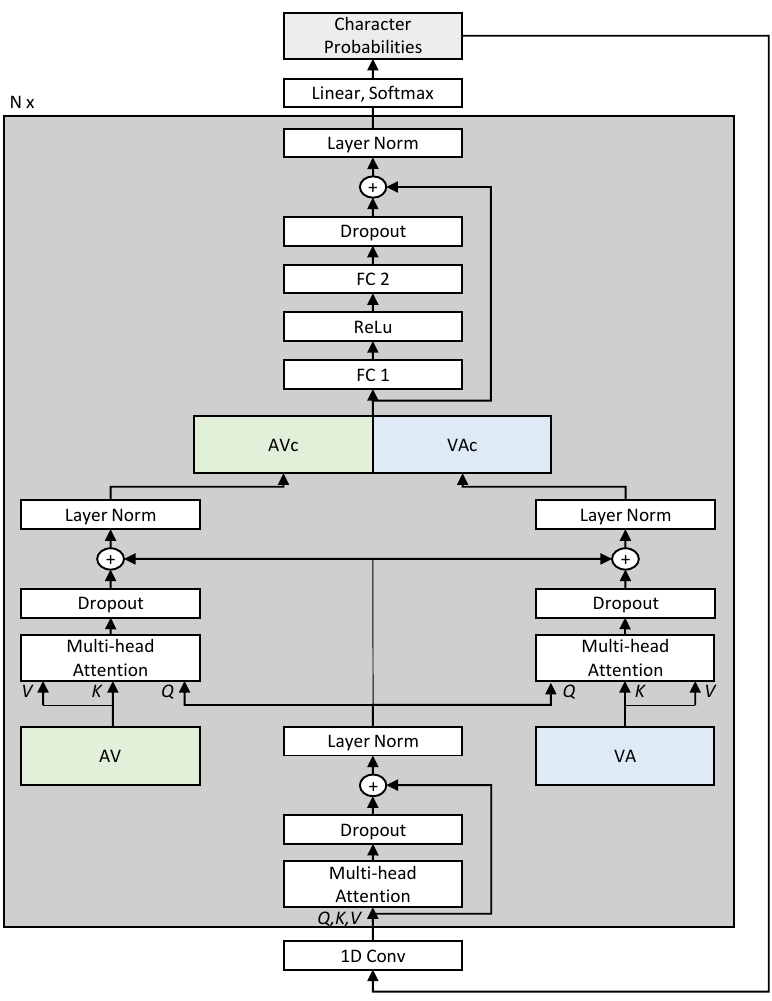
Figure 4. Decoder structure. Similar to the transformer sequence-to-sequence (TM-seq2seq) model, the transformer with DCM attention (TM-DCM) model receives the audio query encoder output (AV) and video query encoder output (VA) and returns character probabilities. Context vectors (AVc and VAc) computed by multi-head encoder–decoder attentions are concatenated channel-wise and fed to feed-forward